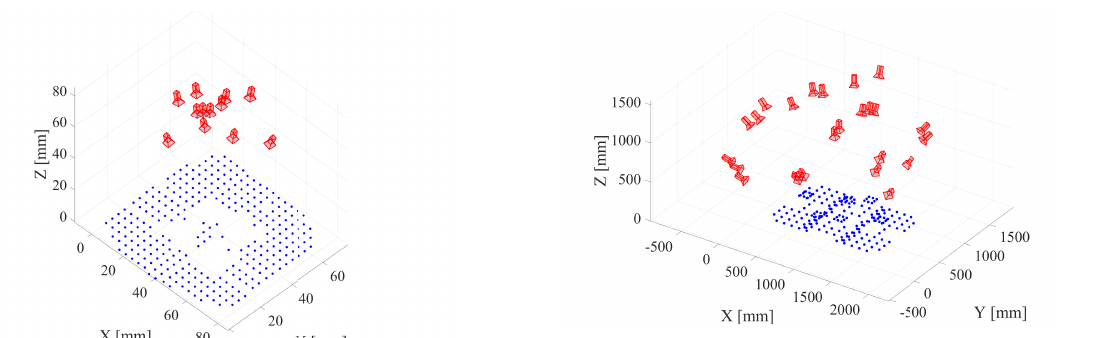
Figure 7. Bundle configuration for the medium-distance data set 2. Cameras are shown in red, points are colored in